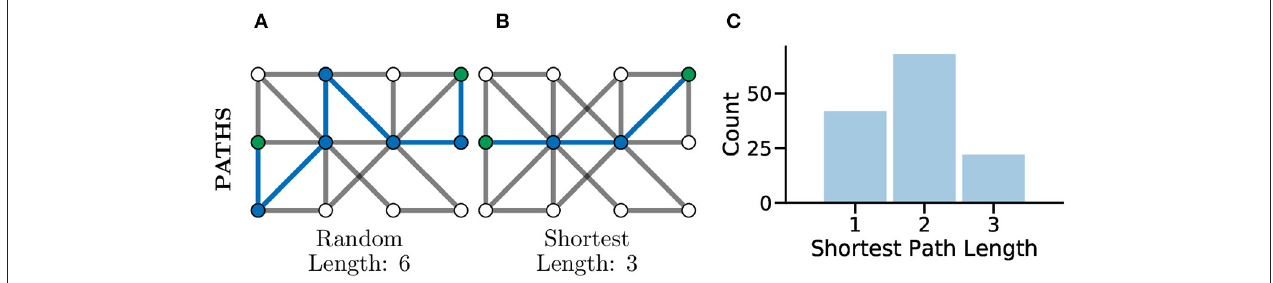
FIGURE 5 | Paths, and especially shortest paths, in graphs give an idea of efficiency of flow or information transfer. Graphs with shorter average paths between nodes may represent networks with very efficient information transfer. (A) An example random path through a graph between the two green nodes. This is not the shortest path but just one of many potential paths. (B) An example shortest path between the same green nodes, there are multiple routes of the same shortest length, between the same two nodes in the same graph. This path represents one of the most efficient routes for information flow in a graph. (C) The distribution of shortest path lengths across all pairs of nodes in a graph can give an idea of flow efficiency in a network. A left-shifted distribution might be expected within connected brain network where neurons may be connected in a highly compact and efficient fashion for fast information processing.